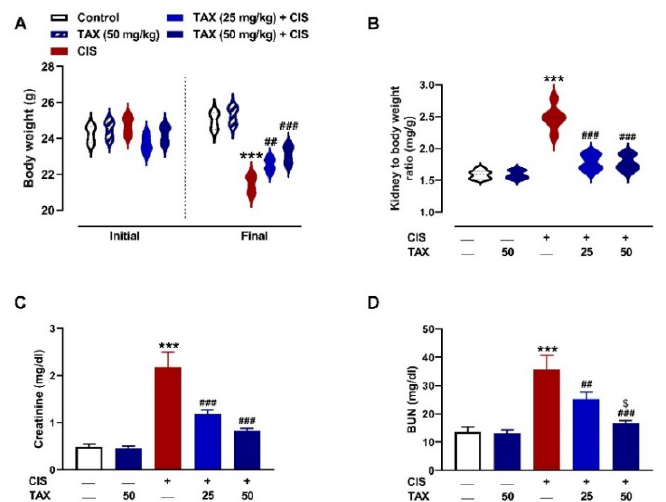
Figure 1. TAX prevented body weight loss ( A ), and decreased kidney weight–to–body weight ratio ( B ), serum creatinine ( C ), and BUN ( D ) in CIS-intoxicate mice. Data are mean ± SEM, ( n = 6). *** p < 0.001 versus Control, ## p < 0.01 and ### p < 0.001 versus CIS, and $ p < 0.05 versus TAX (25 mg/kg).